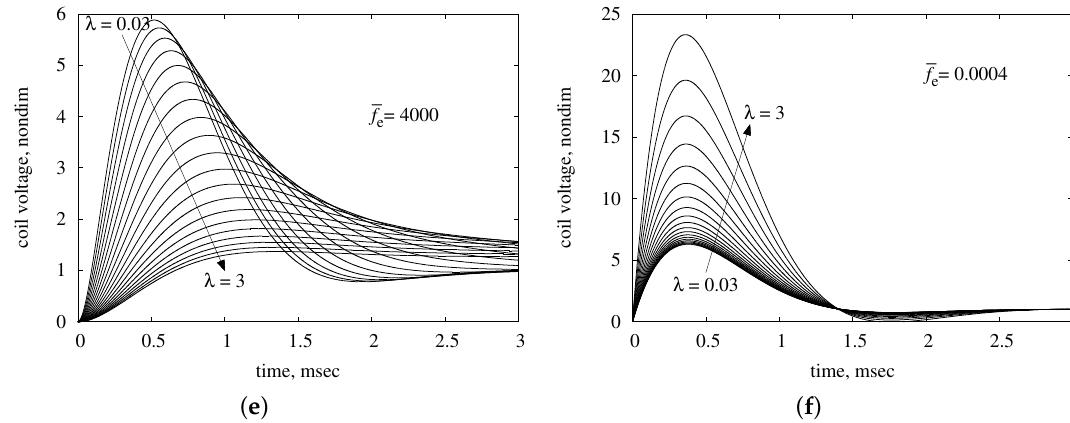
Figure 6. Step responses of the electromagnet-amplifier combination, showing a range of eddy current levels. In the left column are responses for transconductance amplifiers ( ¯ f e = 4000), and in the right column are responses for transpermeance amplifiers ( ¯ f e = 0.0004). The step size was chosen to produce a step change in flux equal to the initial mean flux, Φ 0 . ( a ) Change in non-dimensional gap flux versus time; ( b ) change in non-dimensional gap flux versus time; ( c ) change in non-dimensional coil current versus time; ( d ) change in non-dimensional coil current versus time; ( e ) change in non-dimensional coil voltage versus time; ( f ) change in non-dimensional coil voltage versus